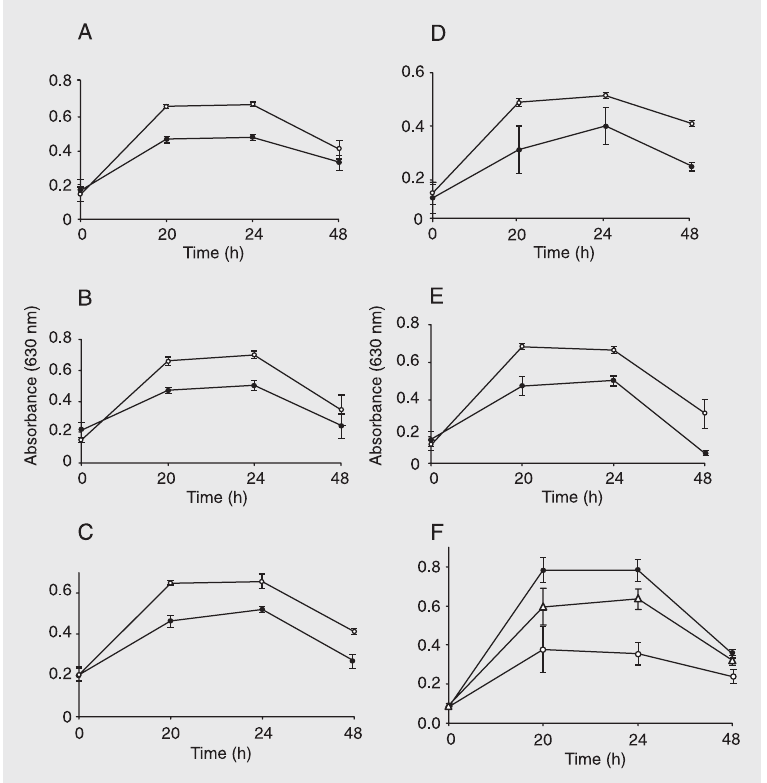
Figure 2. Effect of the Solieria filiformis lectin on the growth of gram-negative and gram- positive bacteria Salmonella typhi (A), Krebsiella pneumoniae (B), Enterobacter aerogenes (C), Proteus spp (D), Pseudomonas aeruginosa (E) and Bacillus cereus (F). Absorbance at 630 nm was used as a measurement of bacterial growth. Control (open circles), 500 µg/mL lectin (triangles), and 1000 µg/mL lectin (filled circles). Data are reported as the mean ± SD for three